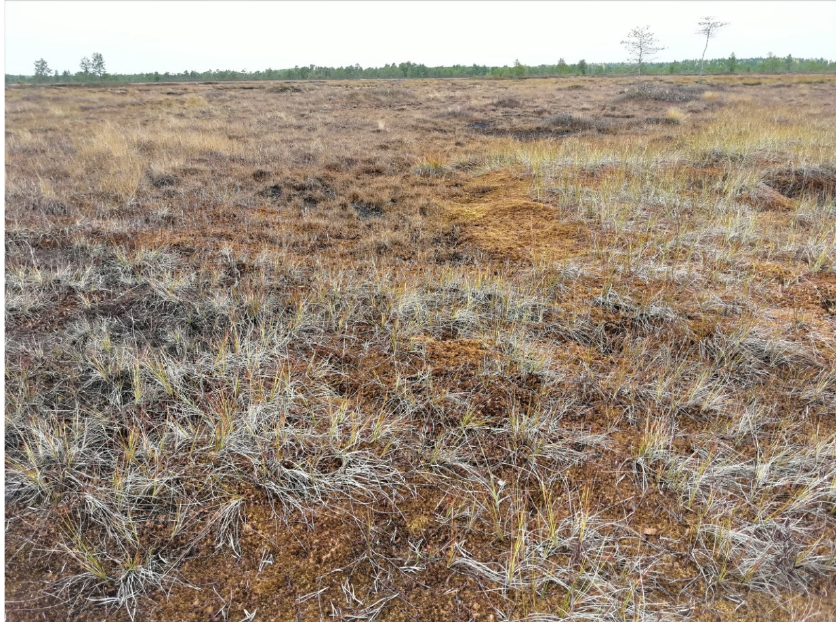
Figure A2. The Ilassky peat bog massif view in autumn (Arkhangelsk Region, Russia).